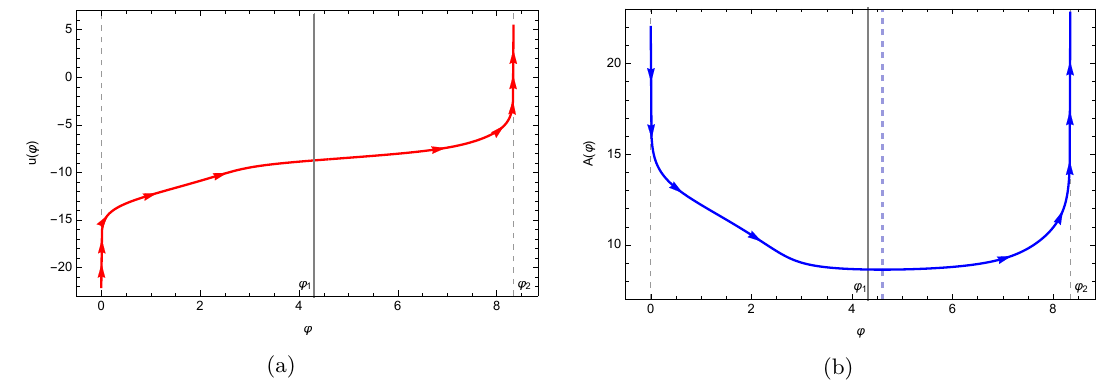
Figure 11 . (a): the holographic coordinate u as a function of ϕ . At UV L ( ϕ = 0 ) it tends to −∞ and at UV ( ϕ = ϕ ) to + ∞ . (b): the scale factor has an A-bounce at ϕ = 4 . 6 (the blue dashed R 2 line) near ϕ , the minimum of the potential. 1